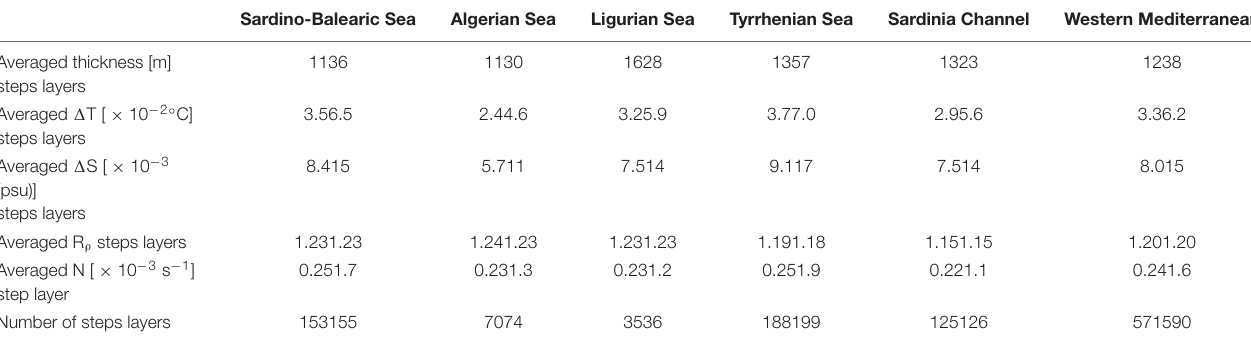
TABLE 2 | Regionally averaged characteristics of steps and layers with 1 < R ρ <